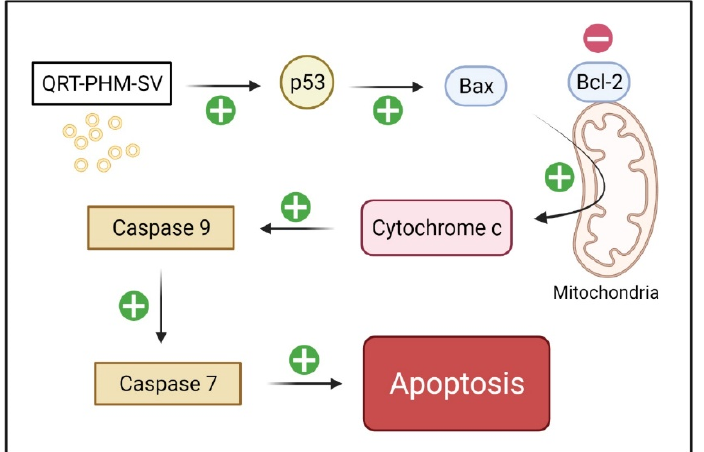
Figure 13. The proposed mechanism of apoptosis triggered by QRT-PHM-SV in MCF-7 cells. The flow chart demonstrates that QRT-PHM-SV induces apoptosis via the mitochondrial pathway and caspase-9-dependent signaling.